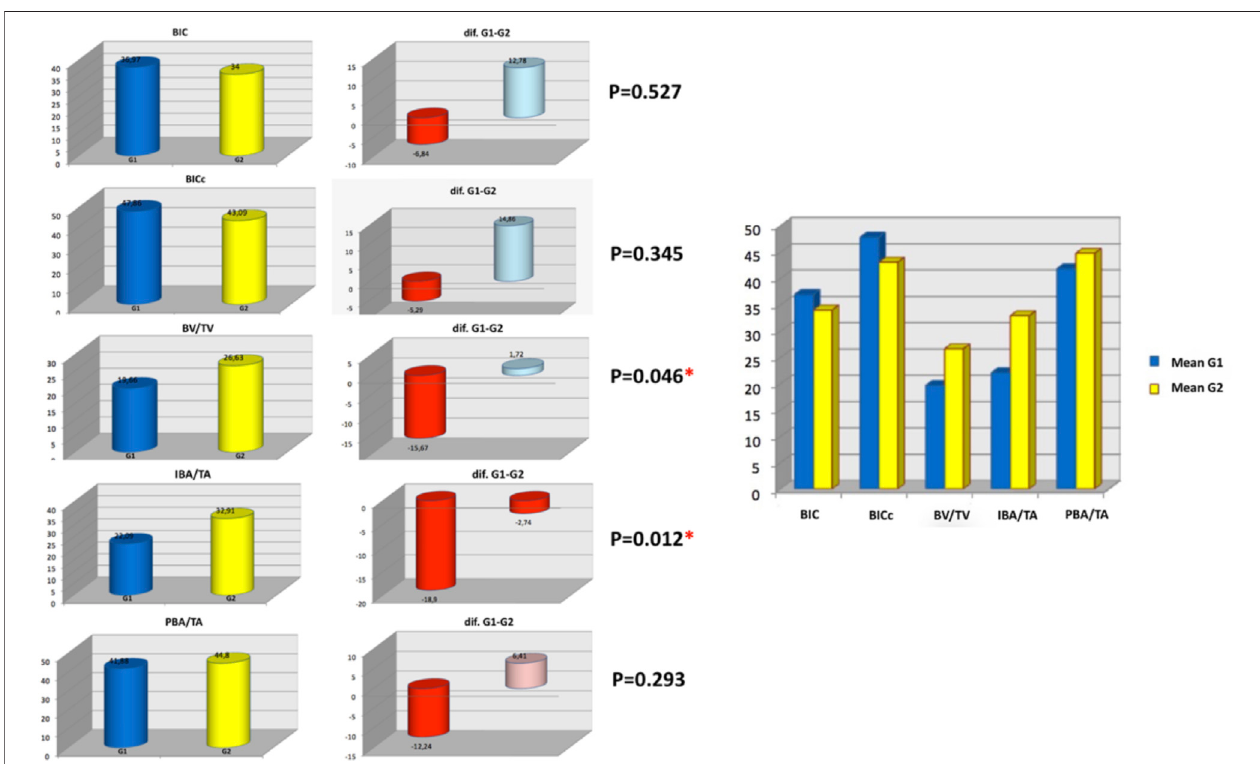
FIGURE 6 | Difference in means between experimental and control